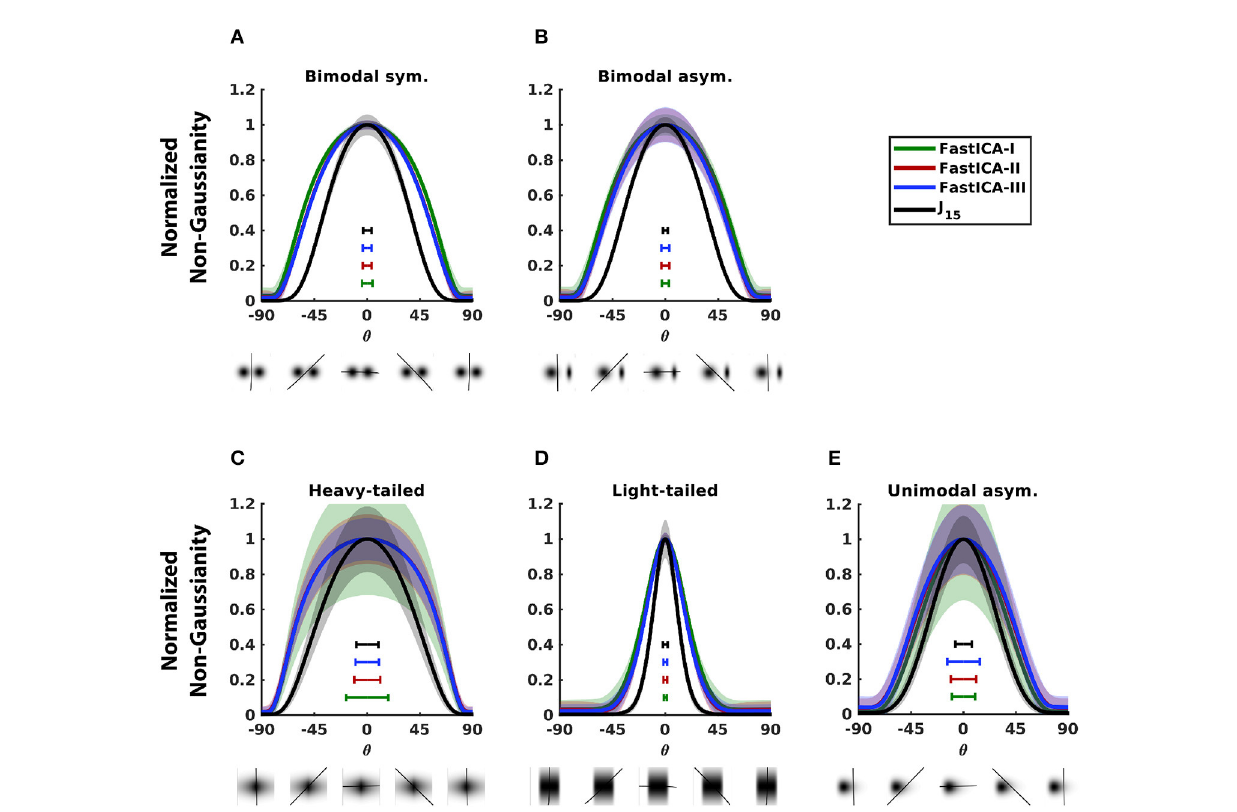
FIGURE3 Comparison of the performance of J 15 to that of contrast functions of FastICA for 2D distributions. Each panel analyzes a distribution consisting of a mixture of a Gaussian and a non-Gaussian distribution chosen from one of the families shown in Figures 1, 2, and is illustrated below each abscissa (see Section 2.4 for details). Non-Gaussianity is assessed for projections onto a range of angles, also illustrated below the abscissae. Results shown for 10 4 samples. (A) Bimodal symmetric distribution. (B) Bimodal asymmetric distribution. (C) Heavy-tailed distribution. (D) Light-tailed distribution. (E) Unimodal asymmetric distribution. Normalization and error bars reported as in Figure 1. For each measure, accuracy is indicated by peak location and precision is inversely related to peak width, as indicated by the horizontal bars within each panel. For further details, see Section